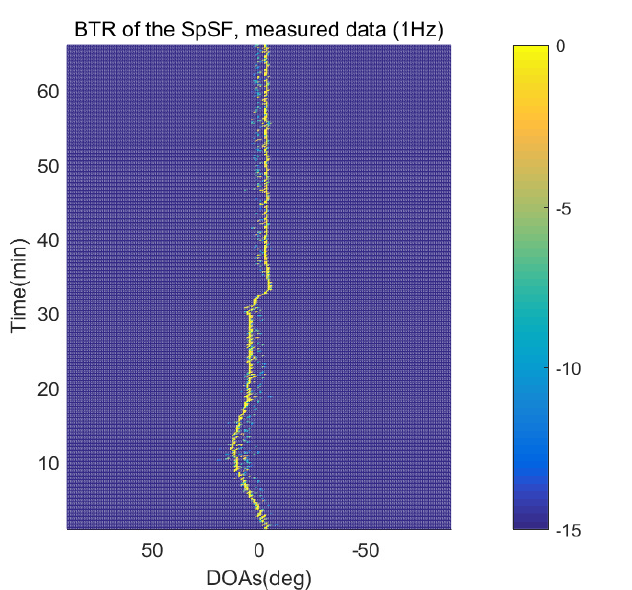
Figure 12. Bearing time records of the SpSF: 66 min, pilot signal frequency = 1 Hz.